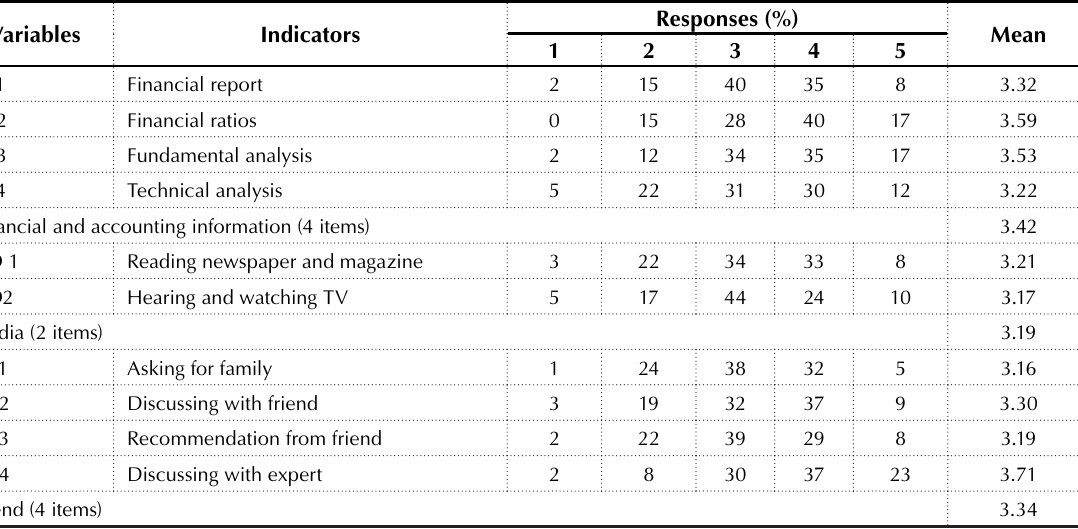
Table 5. Responses to stock market confidence